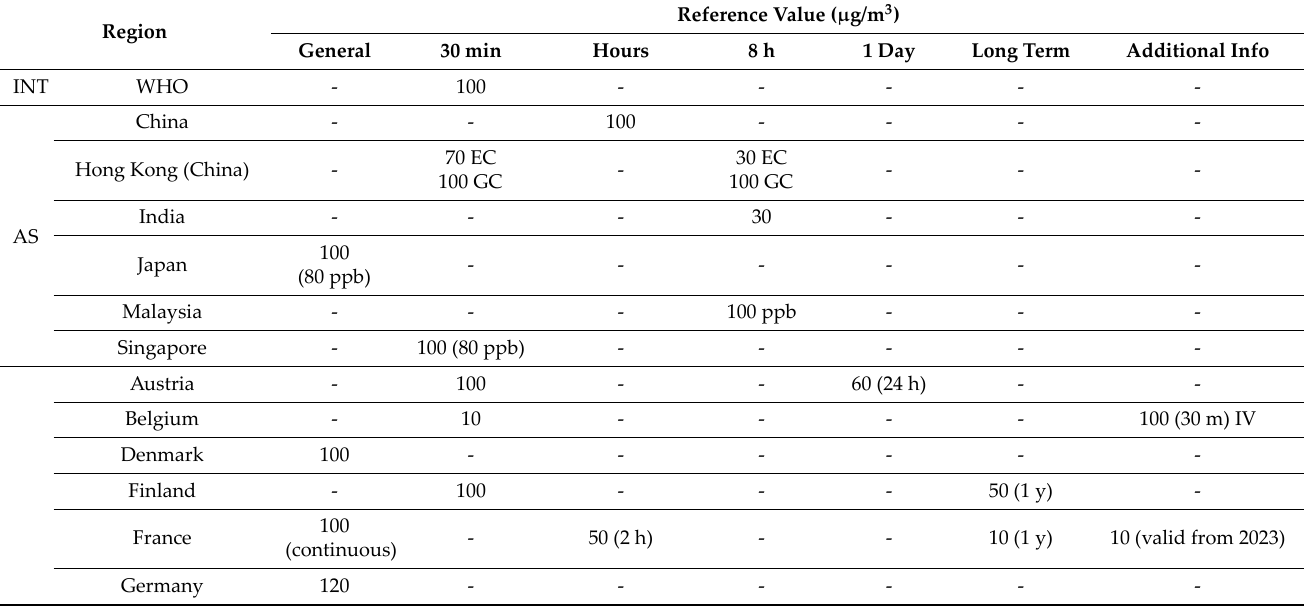
Table 9. Reference values for